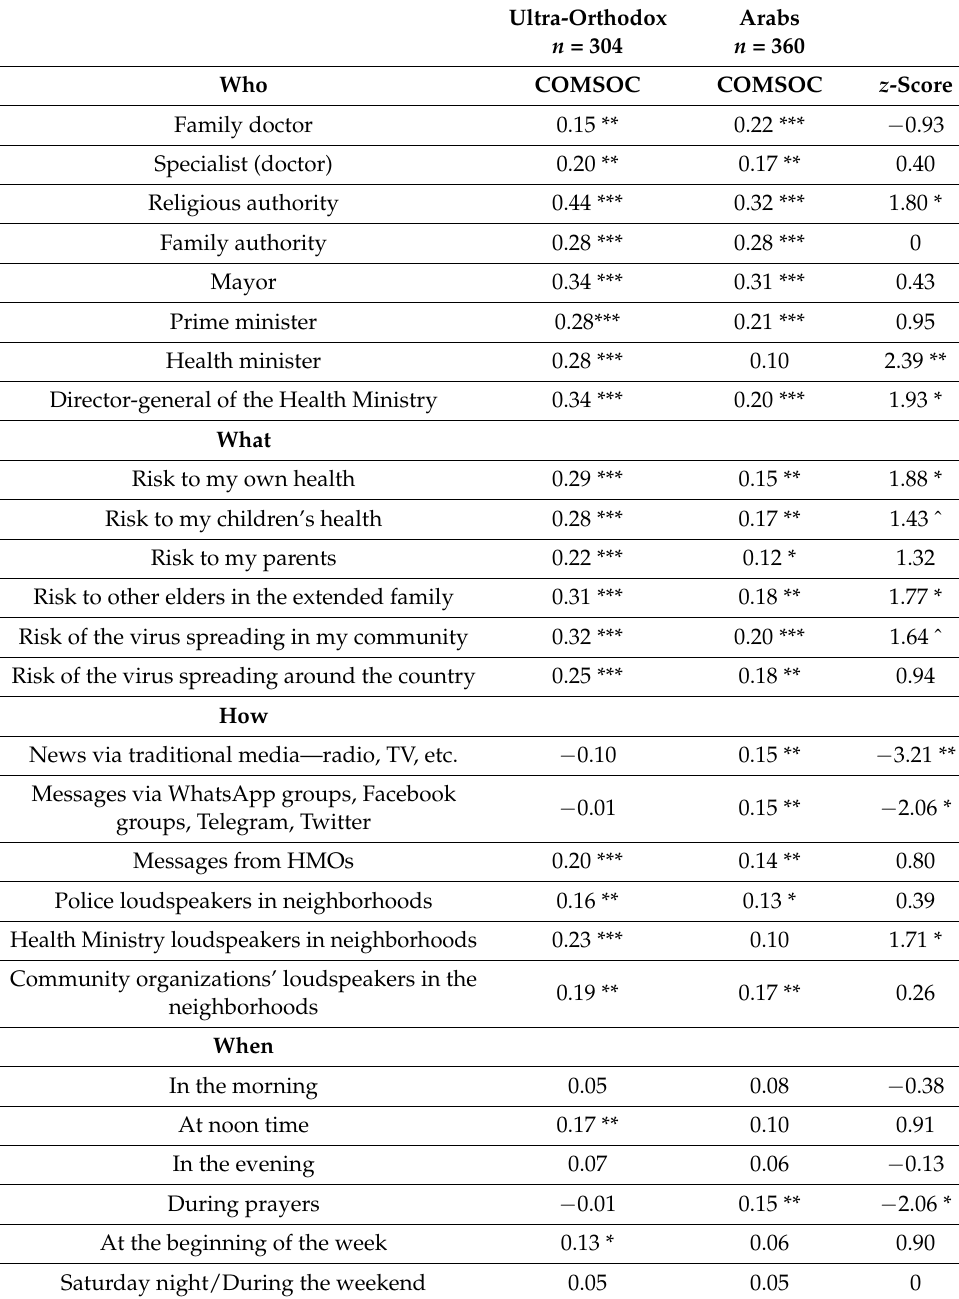
Table 2. Pearson correlations between preferred messaging techniques and community sense of coherence (COMSOC) among Ultra-Orthodox and Arab